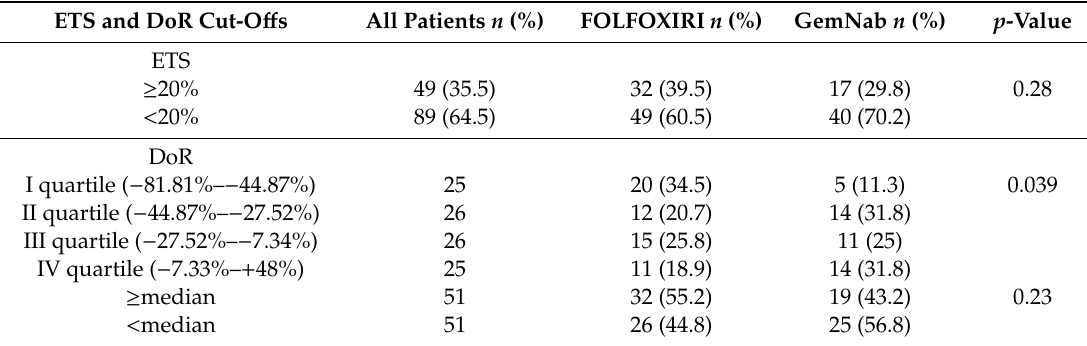
Table 2. ETS and DoR distribution according to treatment.